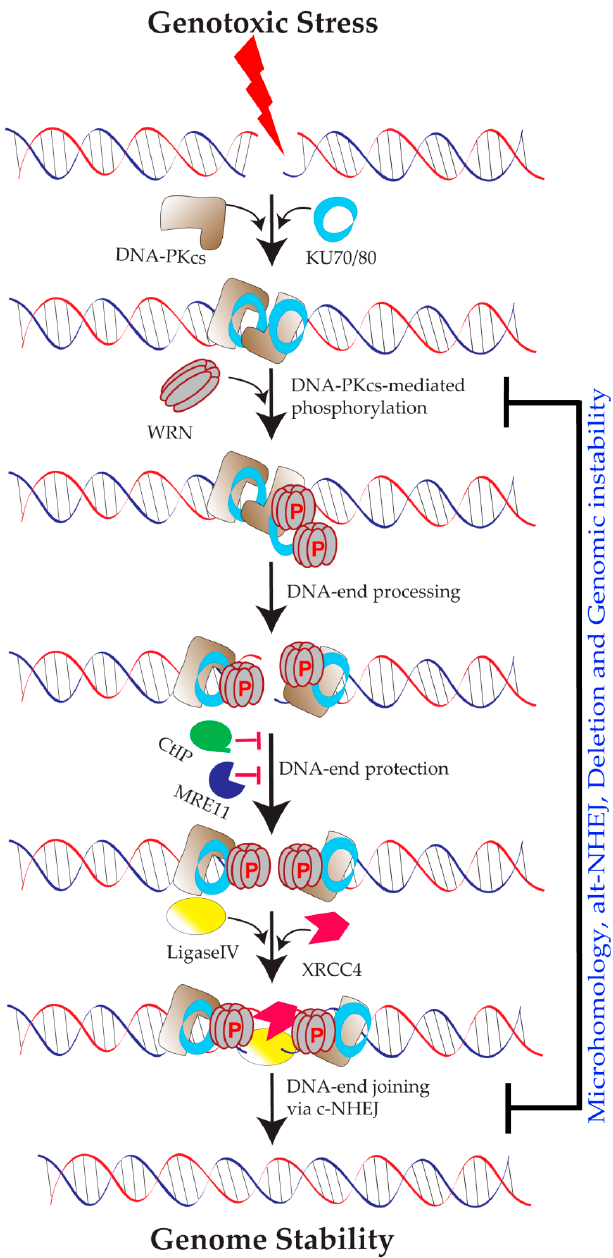
Figure 3. Schematic showing the involvement of WRN in classical non-homologous end-joining (c-NHEJ) pathway-mediated DNA double-strand break (DSB) repair in response to both endogenous and exogenous genotoxic stress. DNA-PK (DNA-PK CS +KU70/80) complex not only recruits WRN to DSB sites but also phosphorylates at multiple amino acid residues in WRN. In addition, physical binding of WRN to damaged DNA prevents excessive enzymatic activities of MRE11 and CtIP. These events are necessary for preventing genomic DNA deletions, microhomology-mediated DSB repair, and alt-NHEJ-mediated DSB repair. DNA-PK CS —DNA-dependent protein kinase catalytic subunit; NHEJ—non-homologous end joining; P—phosphorylation events; XRCC4-X-ray repair cross complementing 4; CtIP-C-terminal binding protein 1 (CtBP1) interacting protein; rose red ⏊ - represents blocking of nuclease activities; red lightening shape arrow denotes genotoxic stress.